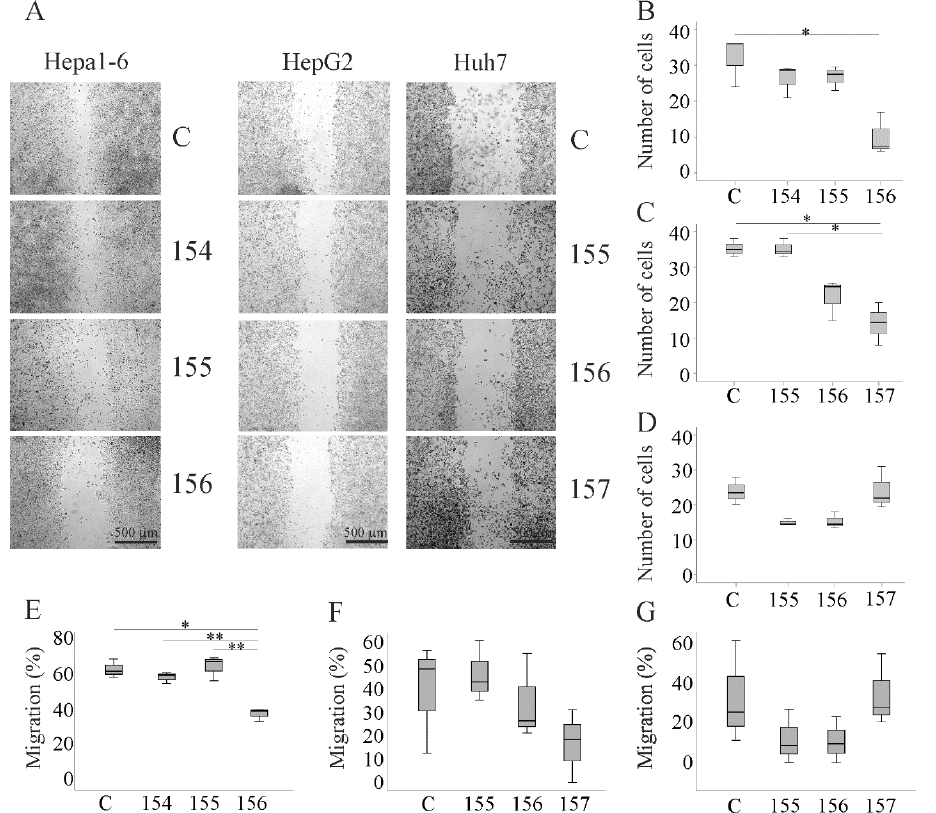
Figure 5. Migration of chemerin isoform-overexpressing Hepa1-6, HepG2 and Huh7 cells. ( A ) Images of the cells at 72 h (Hepa1-6, HepG2) or 48 h (Huh7) after scratching. Number of migrated ( B )